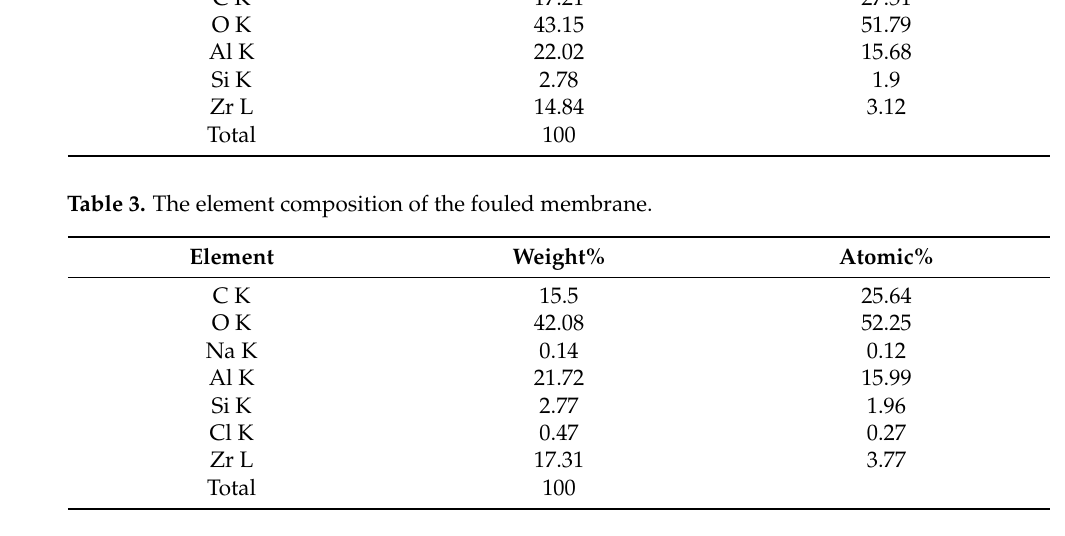
Table 2. The element composition of the virgin membrane.